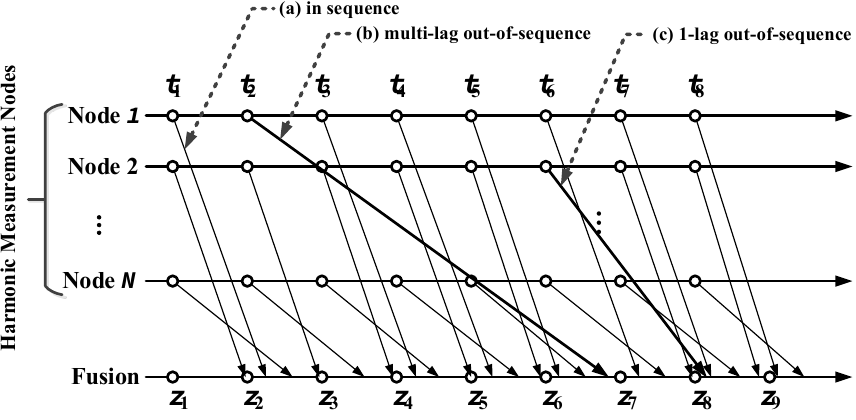
Figure 1. An illustration of the out-of-sequence measurement problem. ( a ) Normal sequence measurement; ( b ) multi-lag out-of-sequence measurement (three-lag delayed in this case); ( c ) one-lag out-of-sequence